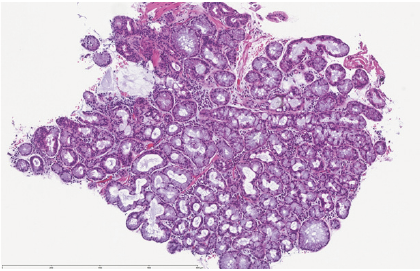
Figure 4: High-magnificationappearance of the salivary gland type glandular tissue showing chronic inflammation.